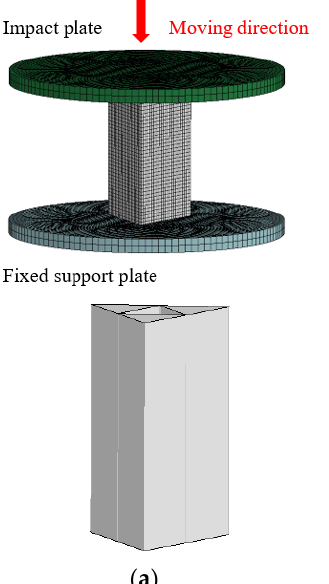
Figure 6. Schematic diagram of the compression process: ( a ) Compression start; ( b ) Slight compres- sion; ( c ) Severe compression.